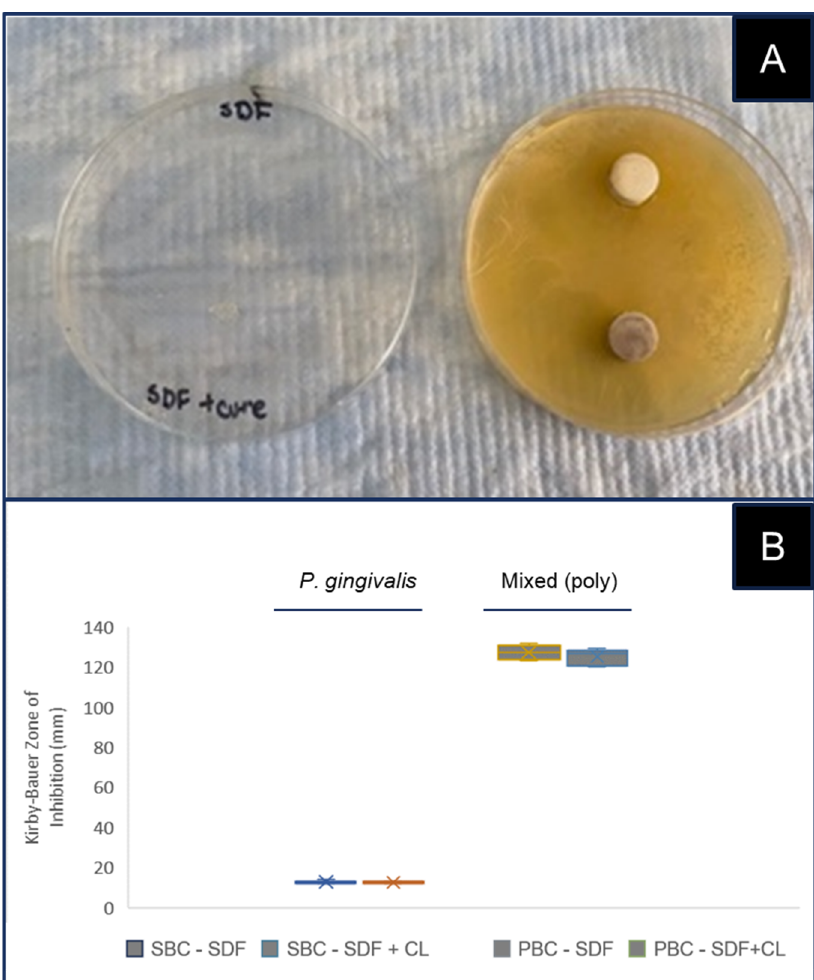
Figure 2. Zone of Inhibition test for antimicrobial activity (ZIT-AA) with Gram-negative and mixed bacterial cultures. ( A ) Visual inspection of ZIT-AA revealed no ZIT-AA with the Gram-negative culture (SDF, SDF with light curing). ( B ) Measurements for ZIT-AA and single bacterial culture or SBC ( P. gingivalis ) for SDF = 12.6 mm, and 12.5 mm with SDF combined with light curing: p = 0.6879. The ZIT-AA for the polybacterial culture or PBC (mixed bacteria) with SDF = 126.4 mm, and 125.8 mm with SDF combined with light curing: p = 0.818. Graph displays box-and-whisker plot, which displays upper and lower quartiles, with mean denoted by X.